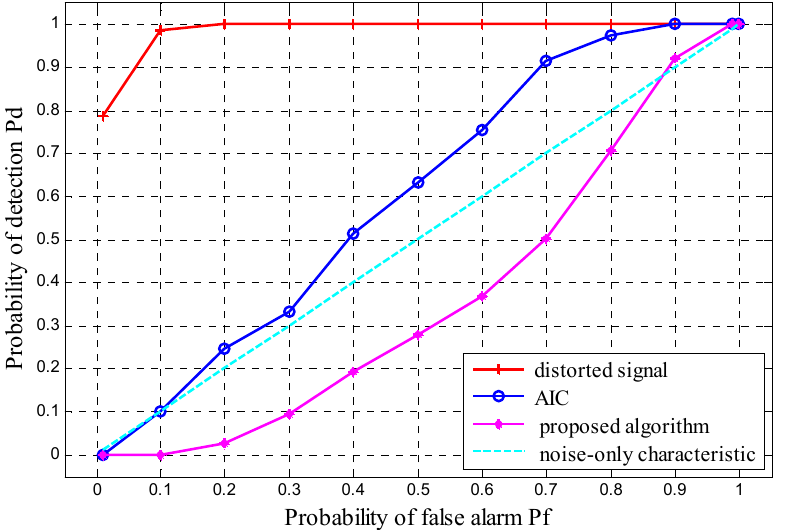
Figure 14. Receiver operating characteristics (ROC) before and after mitigation by different algorithms.